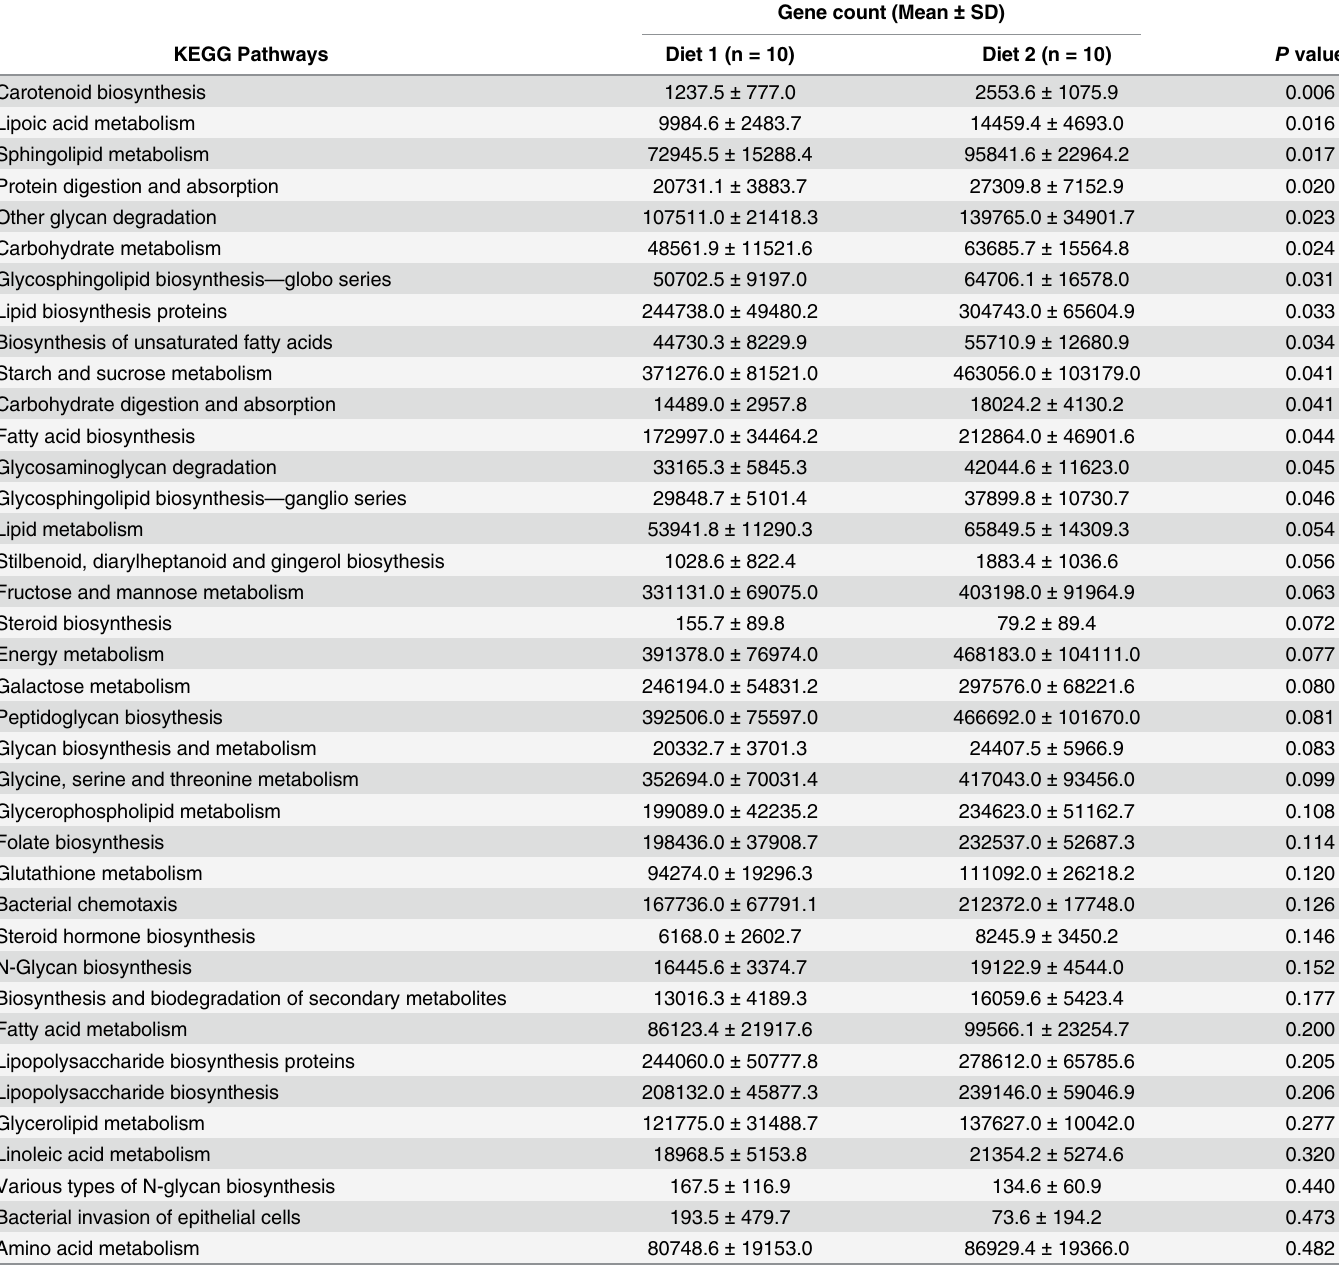
Table 2. Predicted gene counts in microbiota samples from pigs fed diets with and without